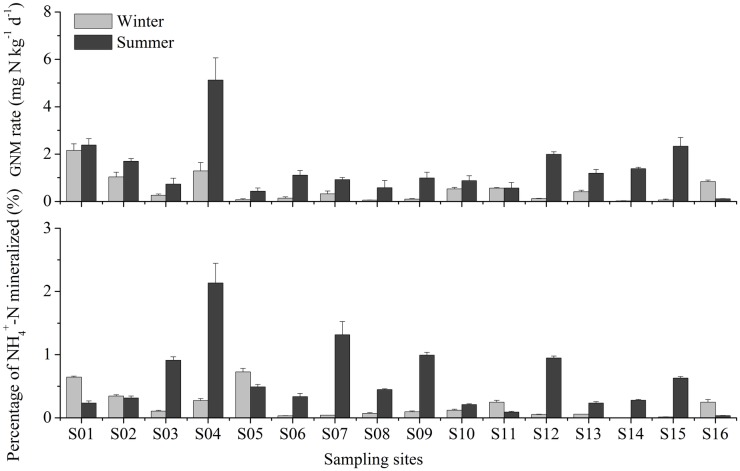
GNM rates and percentages of NH4+-N mineralized per day in surface sediments of the Yangtze Estuary.Vertical bars denote standard error of triplicate samples.